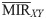
Scatter plots and inferred networks for the financial-markets data.Panels (a), (c) and (e) show the scatter matrix, ordered MIR¯XY values and network of the 15 currency exchange rates. Panels (b), (d) and (f) similarly for the 15 stock indices. The red dash line in (c) corresponds to τ ≈ 0.03 and in (d) to τ ≈ 0.05. Note that in panels (e) and (f), the nodes represent the currency exchange rates and stock indices for the 15 currency areas, respectively, as in Table 1.